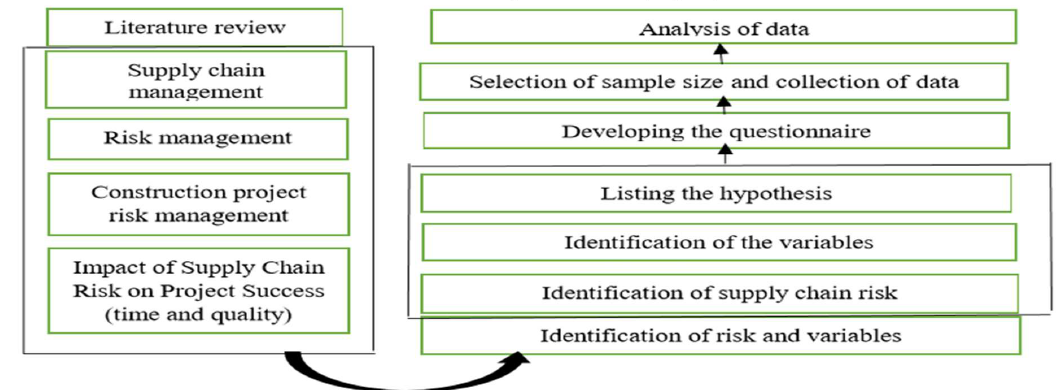
Fig. 1. Dependent and independent variables selected in the study